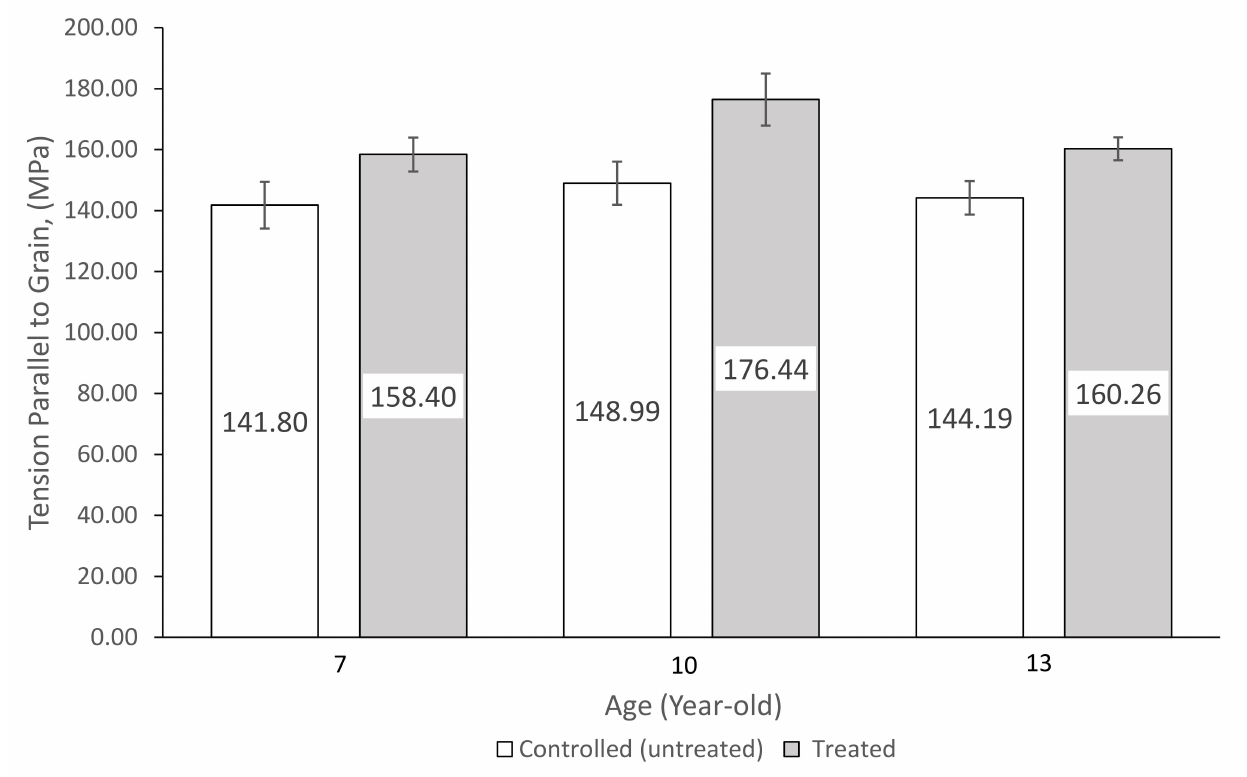
Figure 10. Tension strength values of Acacia hybrid sample compared within the age groups, grain direction, and treatment condition at the air-dry